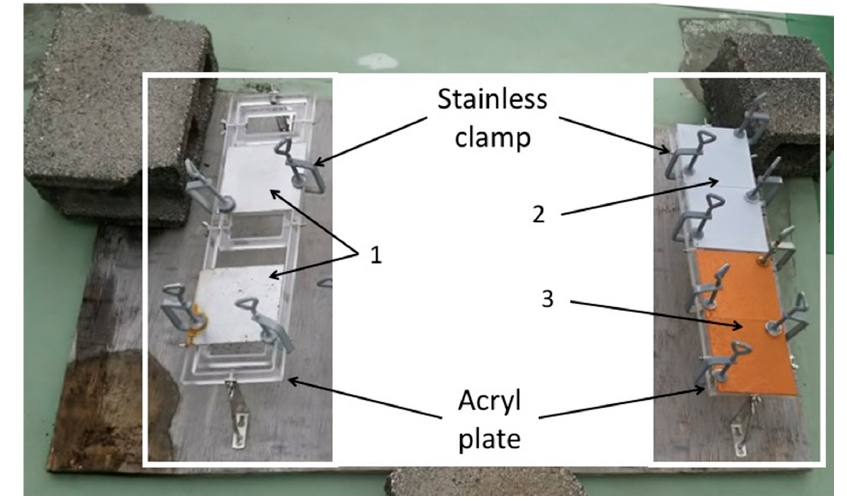
Figure 1. The apparatus for the outdoor exposure test. 1: SS400; 2: Zn-coated; 3: Cu-coated.